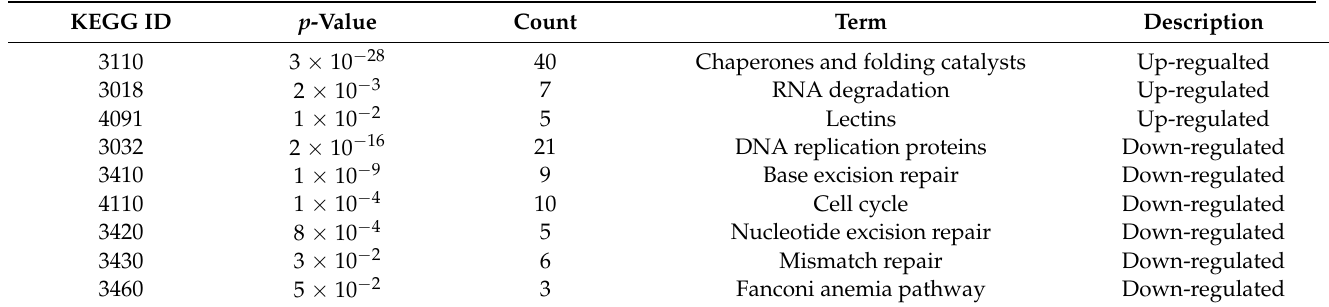
Table 4. KEGG enrichment results after the gradual temperature rise (GTR).